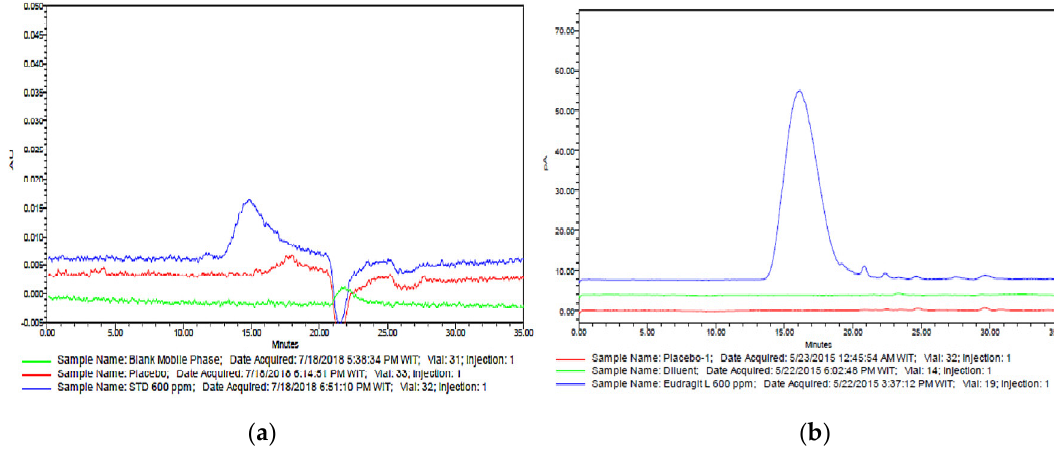
Figure 2. Overlay chromatograms of diluent (green), synthetic mixture (red), and Eudragit ® L100 0.6 mg/mL solution (blue) using ( a ) UV detector at 202 nm; ( b ) charged-aerosol detection (CAD) detector.